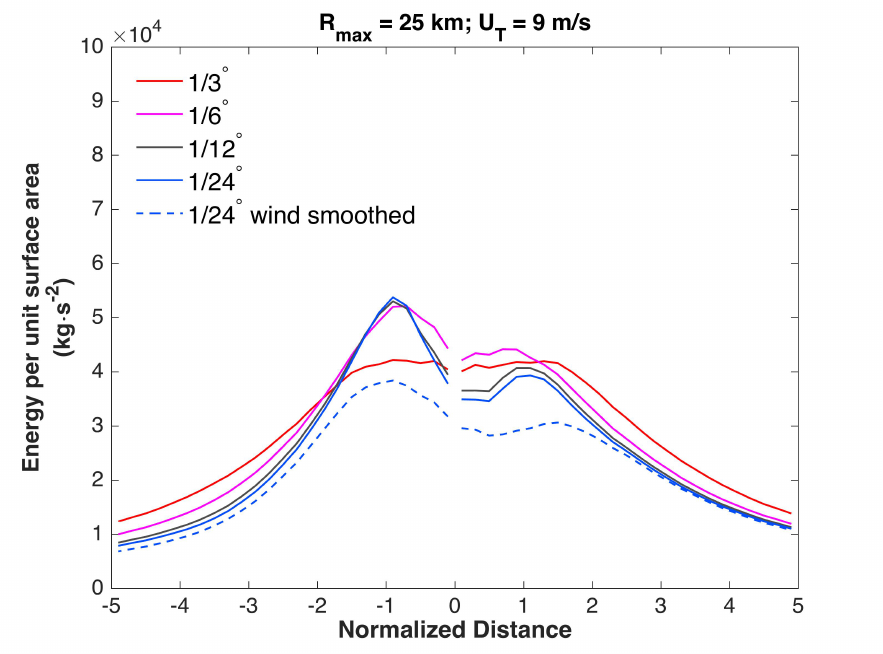
Figure A1. Comparison of the half-annulus averaged wave energy in original experiments (solid lines) and in an additional experiment forced by a smoothed wind field of 1/3 ◦ spatial resolution (dashed